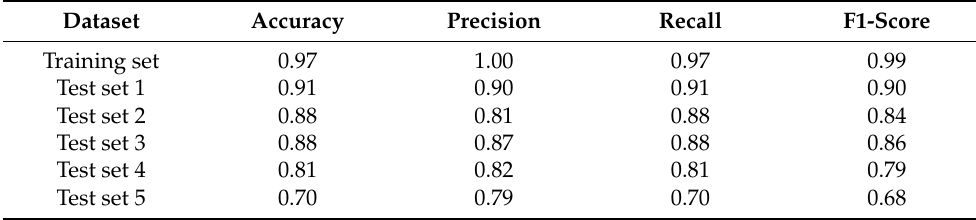
Table 6. Summary of evaluation results for